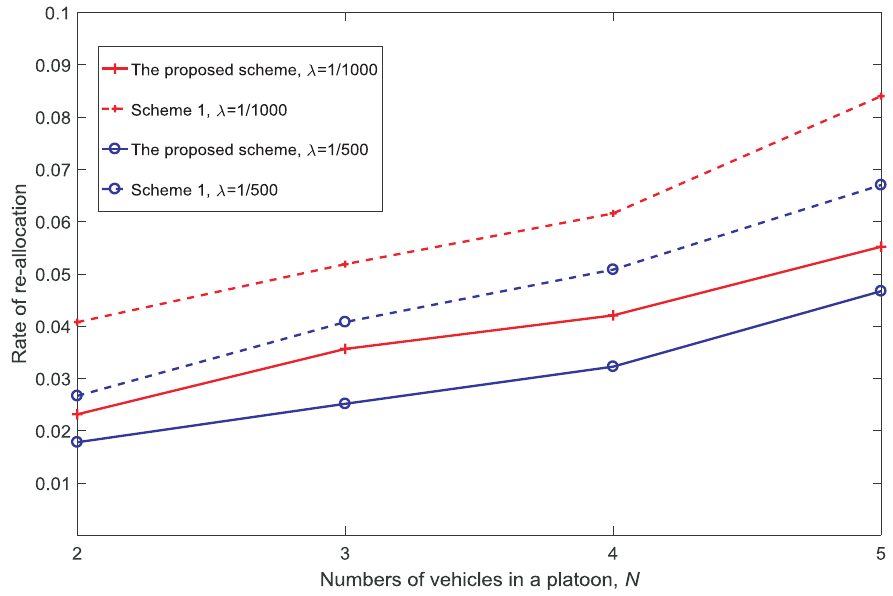
Figure 16. Rate of re-allocation for different numbers of vehicles in a platoon N ( d V = 10, K = 3, V = 10 ) .